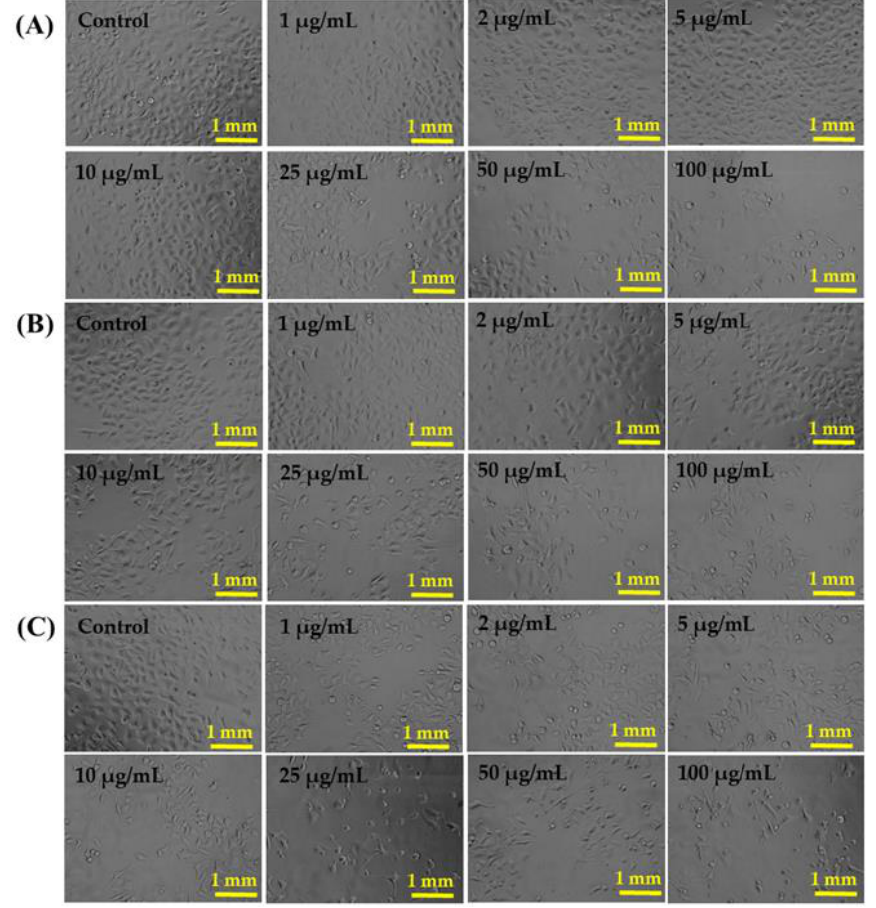
Figure 4. Morphological changes in HepG2 cells exposed to GNPs-1 ( A ), GNPs-2; ( B ), and GNPs-3 ( C ) for 24 h. Cell images were obtained via an inverted microscope at 20× magnification. Scale bar = 1 mm.